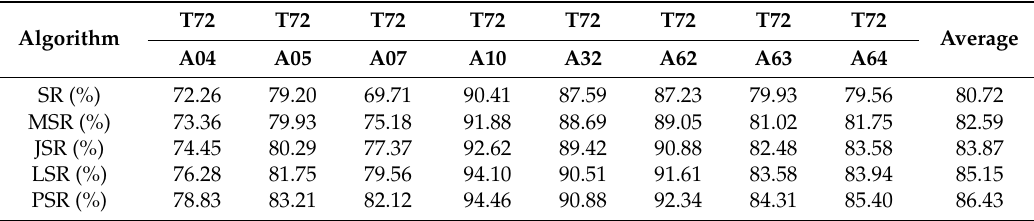
Table 9. The recognition results of the eight T72 configurations under different